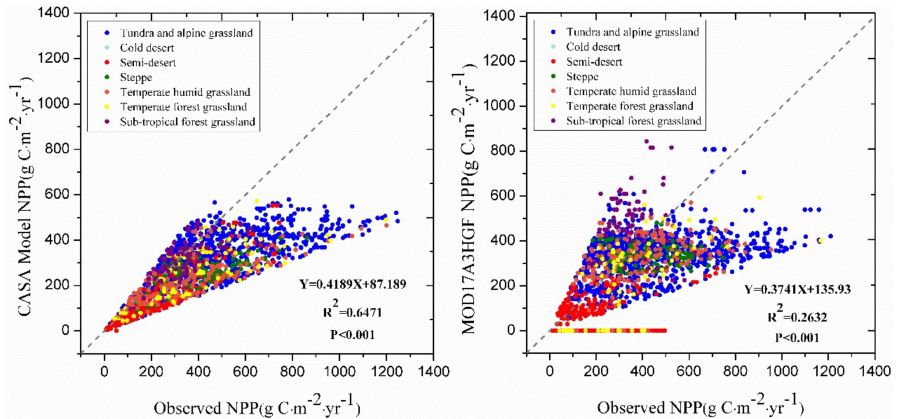
Figure 4. The comparison between the observed and estimated NPP values by CASA ( left ) and MOD17A3HGF ( right ).